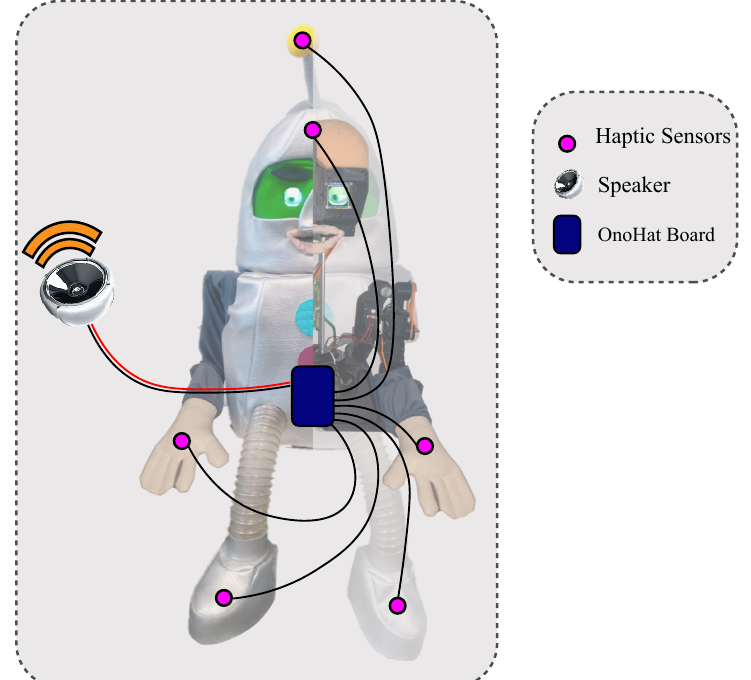
Figure 9. Sensors and the actuator involved in the perception module. The highlighted points represent the haptic sensors, based on Velostat, located on the antenna, head, hands, and shoes. The other elements refer to the board and speaker placed on the lower part of the